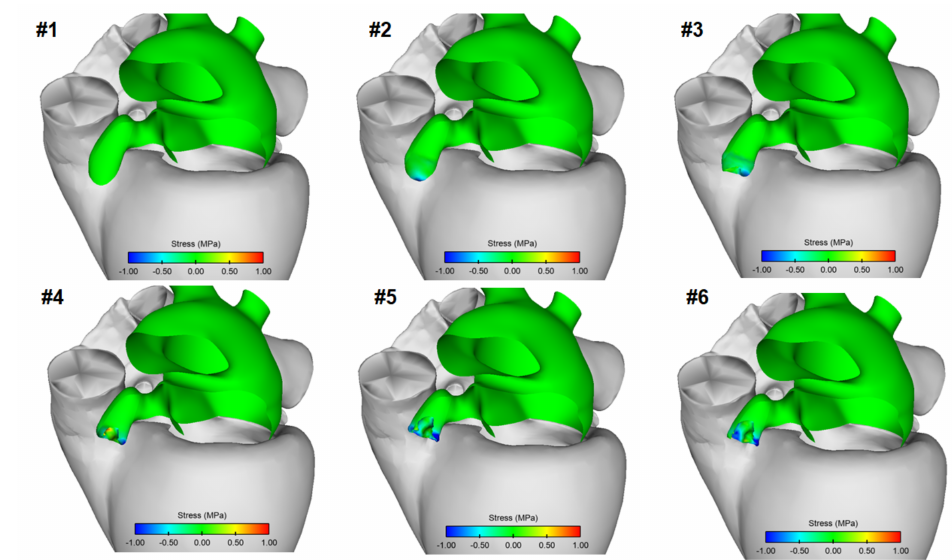
Figure 3. Color-coded stress distributions in the human left atrium during inversion of the LAA. Highest compressive (negative) stress (-1 MPa) is shown in dark blue; highest tensile (positive) stress (1 MPa) is shown in dark red. The progression of the procedure is from #1 to #6 . #1 : Baseline, before any LAA inversion. #2 : LAA is 20% inverted; compressive stress is seen near tip of LAA. #3 : LAA is 40% inverted; compressive stress is seen over a larger portion of the LAA. #4 : LAA is 60% inverted; compressive, as well as some tensile stress, is visible in LAA. #5 : LAA is 80% inverted; only compressive stress is visible in LAA. #6 : LAA is 100% inverted; only compressive stress is visible in LAA.